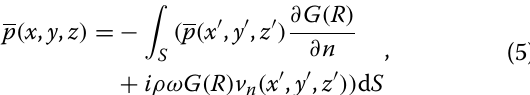
Figure 7. The black solid line in the upper graph is the train speed. The lower graph shows that the calculated and measured results are in good agreement when the train speed is increased to a certain level. On the con- trary, when the speed is lower or the train is motion- less, there is a considerable difference between the two results. This is because wheel-rail noise is insignificant when the speed is low, and the interior noise is mainly affected by the auxiliary equipment, e.g., air condition- ing and car radio. As a result, the measured values are considerably higher than those calculated based only on wheel-rail noise. It can be concluded that the interior noise calculation method is reliable when the wheel-rail noise is the dominant sound source. With this premise, an accurate wheel-rail noise prediction model is the most important aspect that should be established. The wheel-rail interaction deforms the contact area. The roughness with wavelength shorter than the size of the wheel-rail contact area does not have any excitation effect on the wheel-rail system, this is called contact filter. A filter function, adopted from Ref. [20], is expressed by